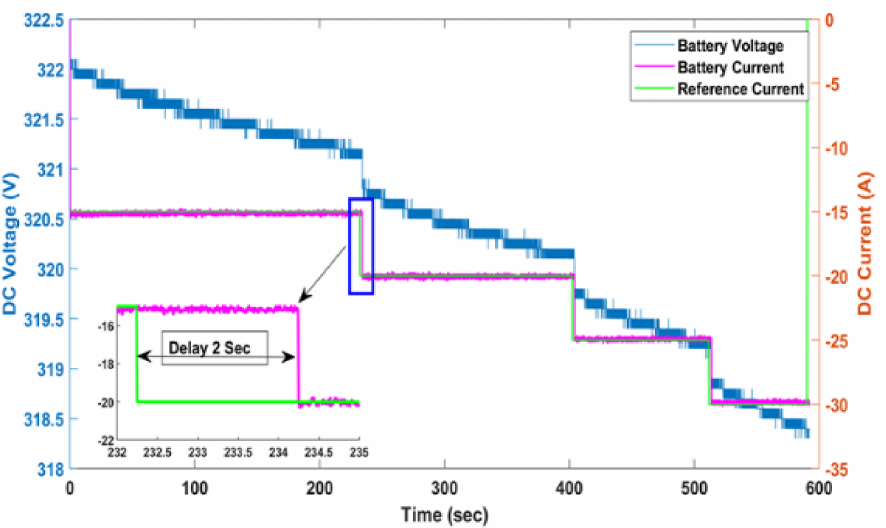
Figure 12. Measurement of DC voltage and current with reference value via CAN communication over the full testing